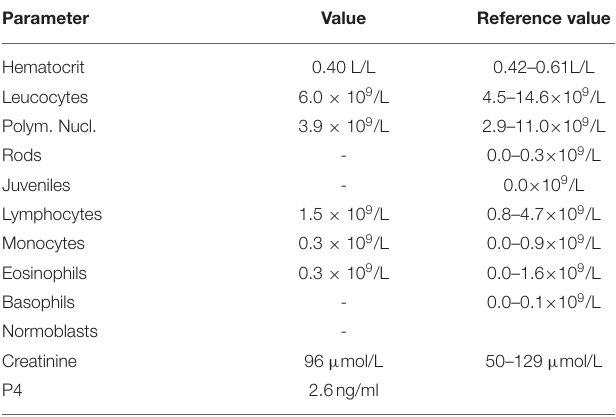
TABLE 1 | Results of hematological, biochemical, and endocrine analyses on D69.